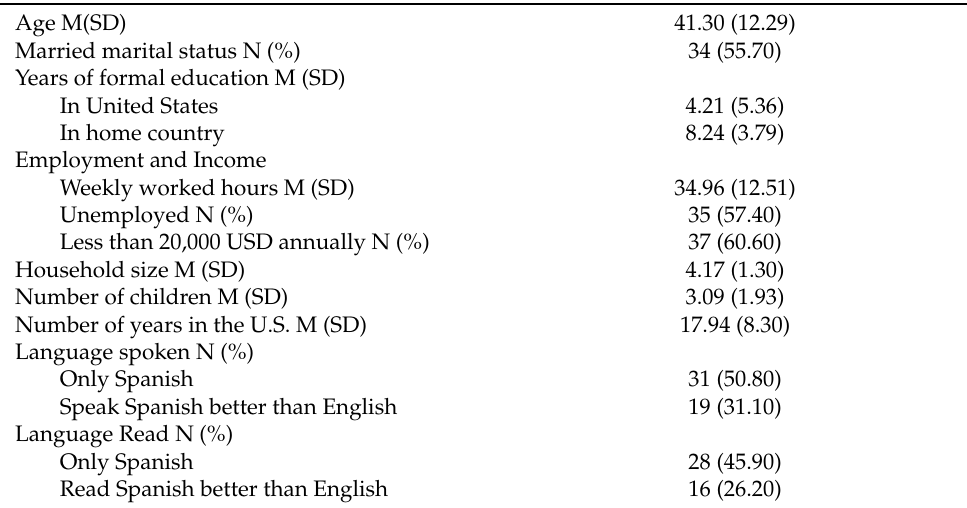
Table 1. Parent Demographic Characteristics (N =